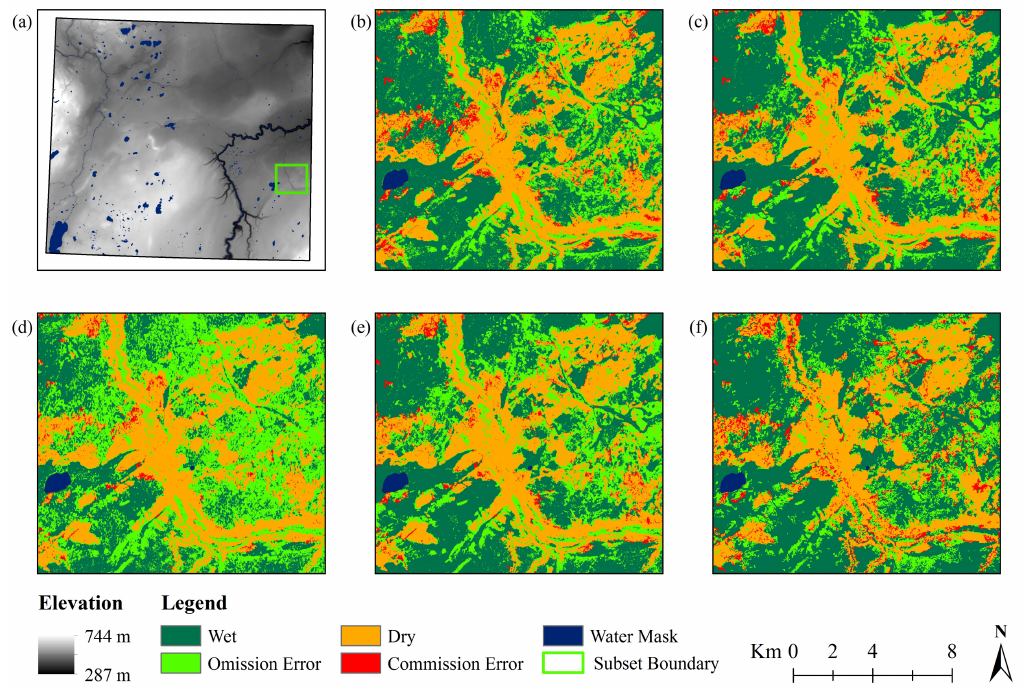
Figure 10. Local variations in classification errors for the area located within a southeastern subsection of the study area delineated by the green box in ( a ), for ( b ) T model , ( c ) TO model , ( d ) TS model , and ( e ) TOS model models, as well as ( f ) the AMWI. Equivalent subsection to that shown in Figure 8.